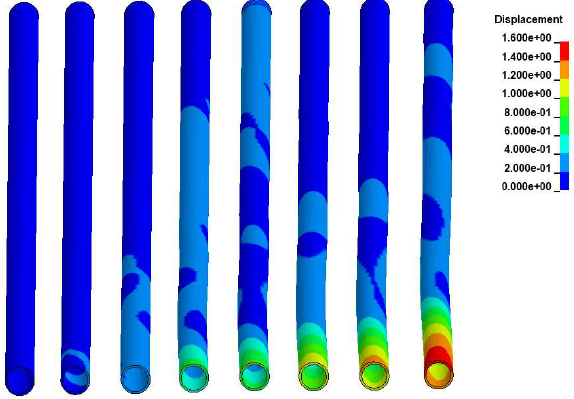
Figure 11. Displacement of string during perforating.